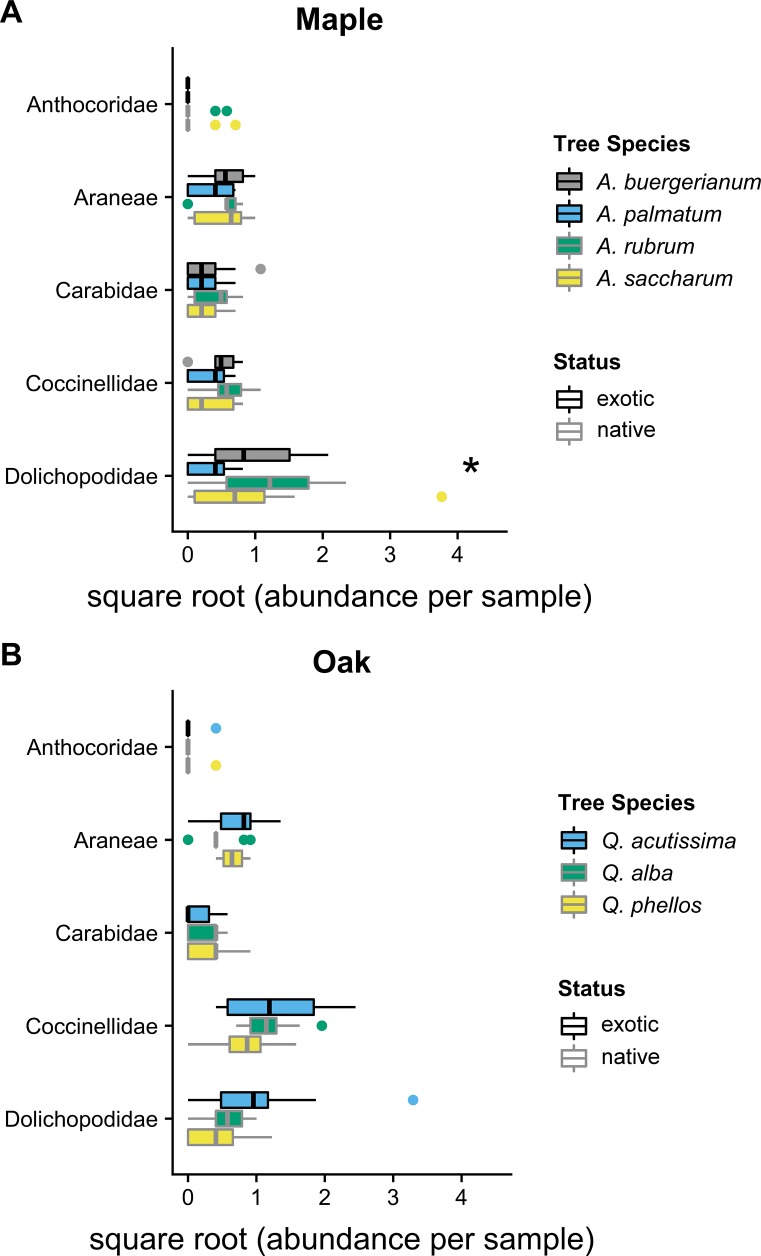
2016 predator communities.Abundance of predators in five taxa in 2016 for (A) maples and (B) oaks. Colored boxes mark the interquartile range (IQR), and whiskers extend to the largest value within 1.5 * IQR. Values beyond 1.5 * IQR are marked as points. Exotic species are outlined in black. Predator taxa that differed significantly between tree species in univariate tests are marked with * (Tables S1 and S2). Global tests indicated significant differences in the predator communities of maples and oaks (p < 0.05), where A. palmatum was different than other maple species and Q. acutissima was different than other oak species (Tables S1 and S2).